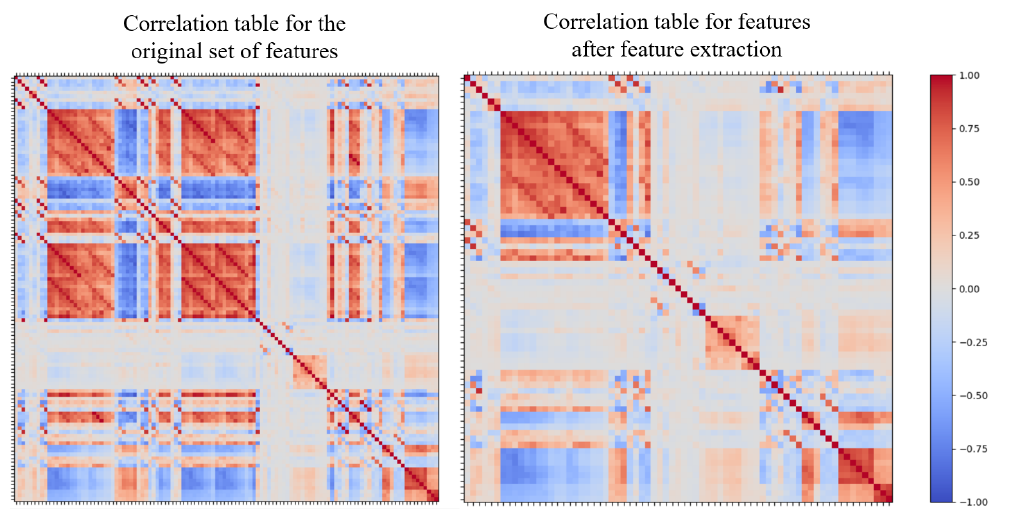
Figure 5. Correlation table before and after feature